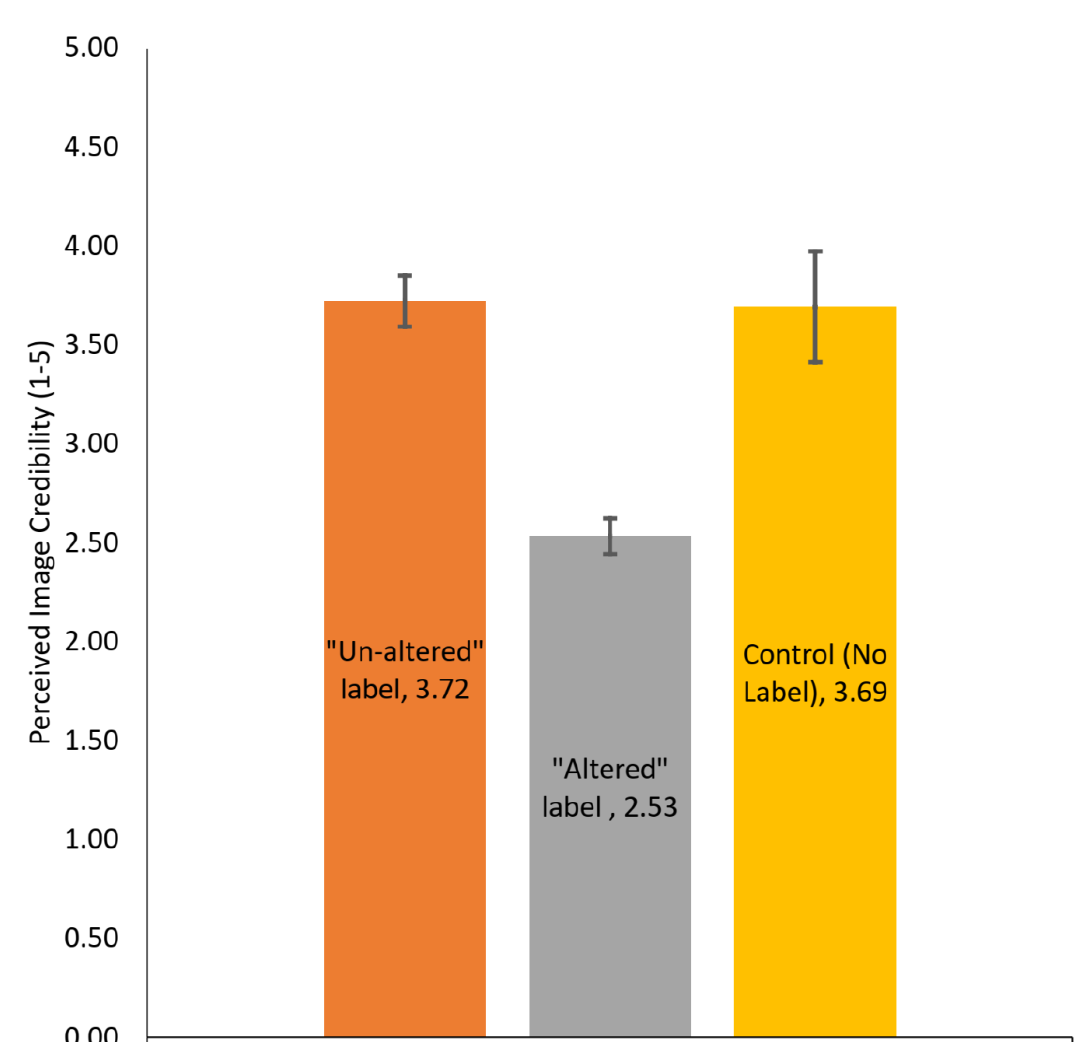
Figure 1. Average image credibility rating by labeling condition . The “Altered” label condition was significantly lower than the control condition, while the “Un - altered” label condition did not differ significantly from the control condition. Error bars represent 95% confidence intervals for the